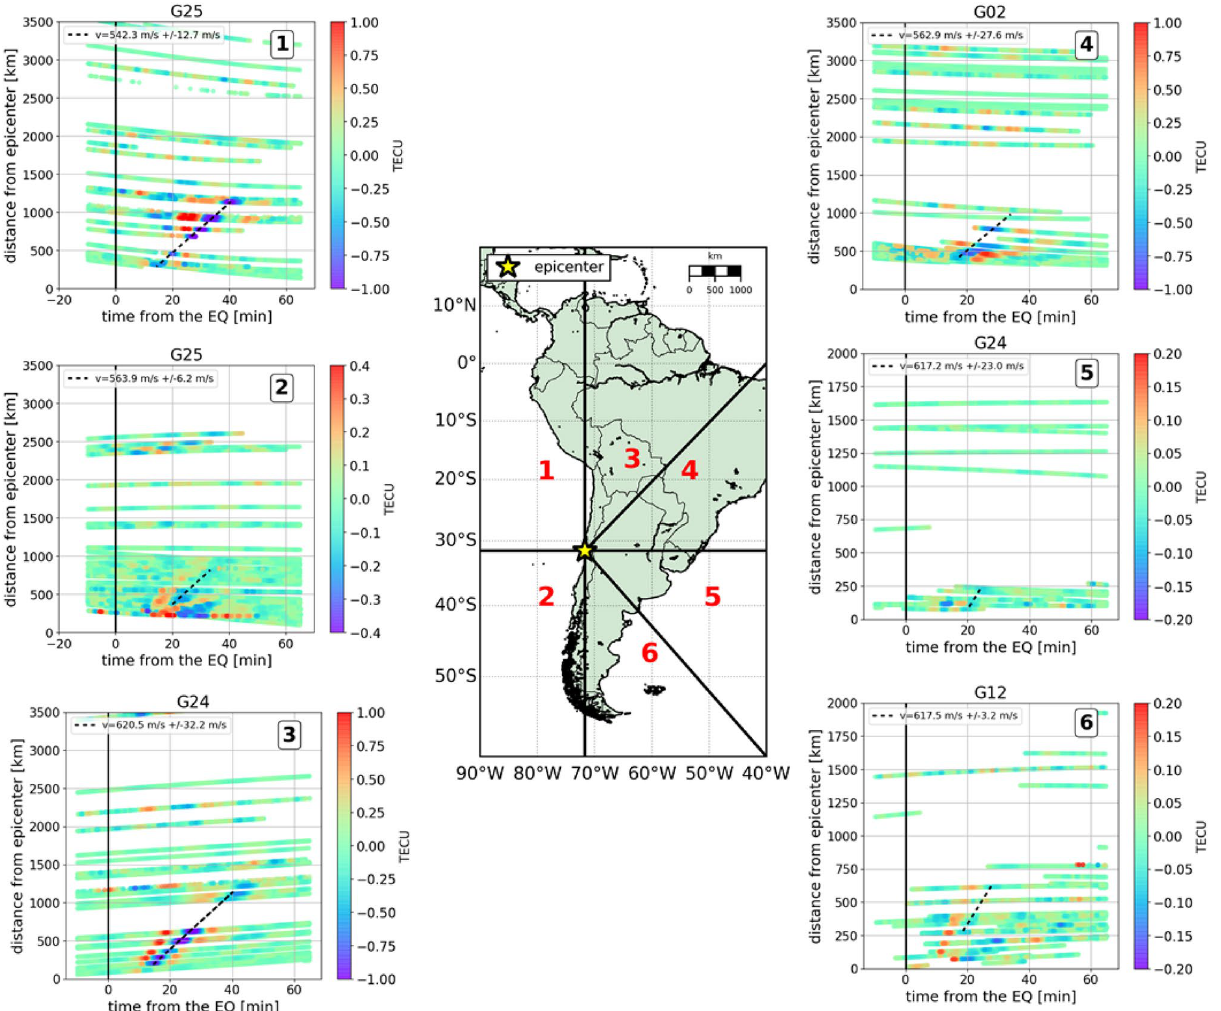
Figure 7. Map indicating the division in six regions of the studied area making the epicenter the area center. The two western sectors (1 and 2) are mainly placed over the Pacific Ocean, while the four eastern sectors (3, 4, 5 and 6) are mainly placed over land. Hodochron plots for the 6 regions identified computed for a time interval of one hour and 15 min (from 22:45:00 to 23:59:59 GPS time) and for some satellites in view (cut-off angle of 20 from all the 118 GPS stations. The number in the upper right box denotes the region to which the hodochrones belong. The slope of the straight line fitted, considering a linear least-squares regression for corresponding sTEC minima for different satellites, represent the AGW epi horizontal propagation